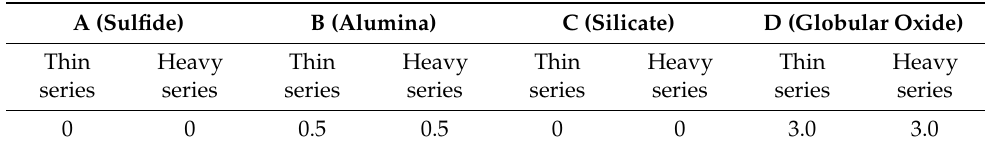
Figure 6. ( a ) Non-uniform hardened cross-section shaft layer. Red arrows indicate the hardened layer with a width less than 2 mm; ( b ) inclusions present in the shaft. Red arrows indicate the hardened layer; ( c ) frequency distribution of the inclusions areas at the subsurface of the shaft. Table 3. Classification and severity of inclusions.